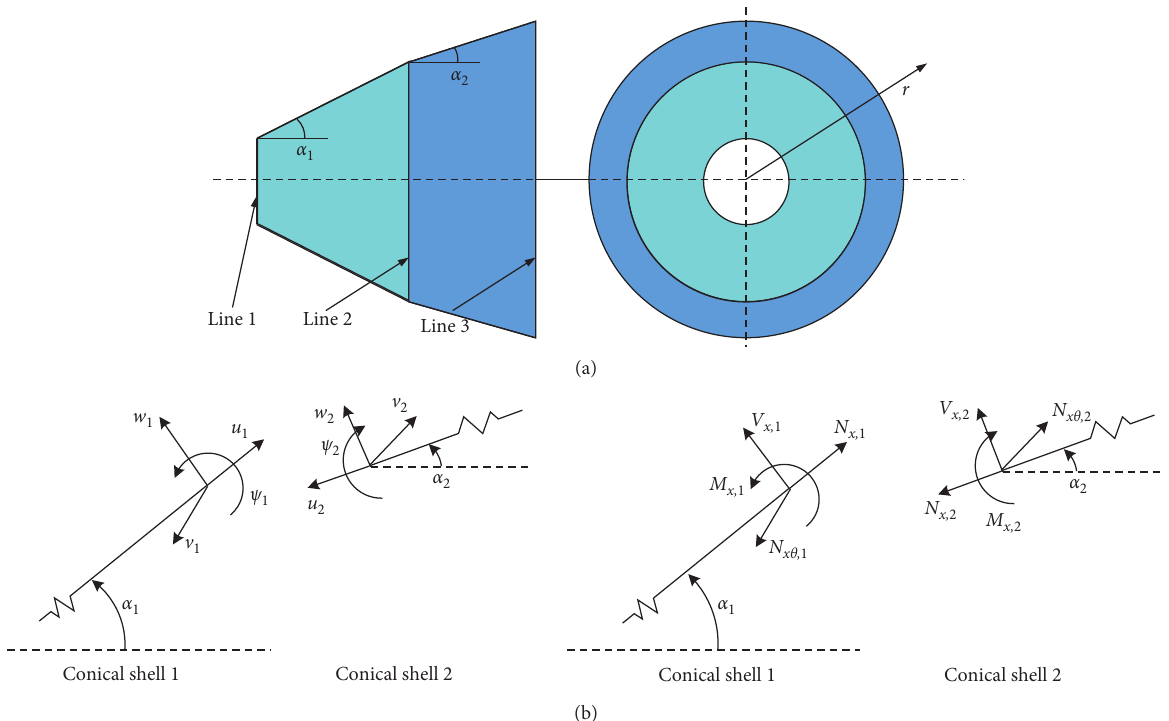
Figure 3: Sketches of (a) joined conical shell and (b) coordinating relationship of displacement and internal force along the coupling boundary of joined conical